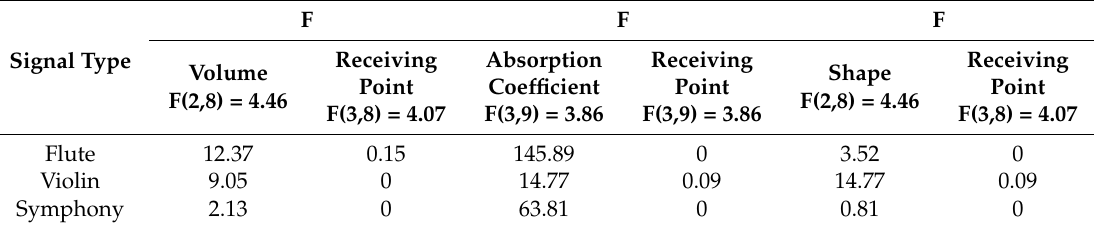
Table 8. Results of two-factor nonrepetitive experimental variance analysis. F(n 1 ,n 2 ) denotes the value in the F distribution table with freedom degree of n 1 and n 2 . It is hypothesized that the factors have no significant impact on the auditory perception. When the calculated F is less than F(n 1 ,n 2 ), the hypothesis is accepted. When the calculated F is larger than F(n 1 ,n 2 ), the hypothesis is rejected; the factor is considered to impact auditory perception significantly.